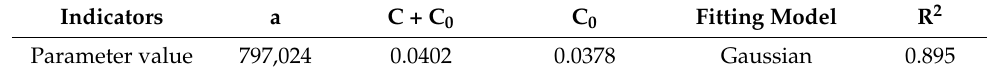
Figure 5. Hot spots pattern of rural settlements scale in Nanjing. Table 1. Fitting parameters of variation of rural settlement morphology distribution.